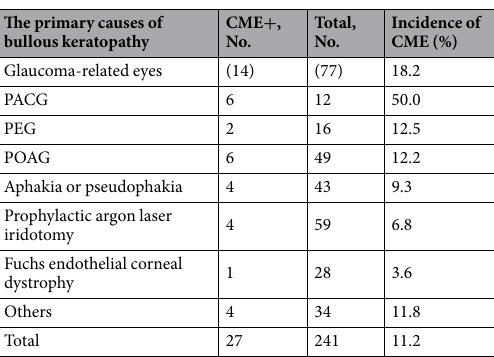
Table 1. Incidence of postoperative CME according to the primary causes of bullous keratopathy. CME: cystoid macular edema, PACG: primary angle-closure glaucoma, PEG: pseudoexfoliation glaucoma, POAG: primary open-angle glaucoma, No: